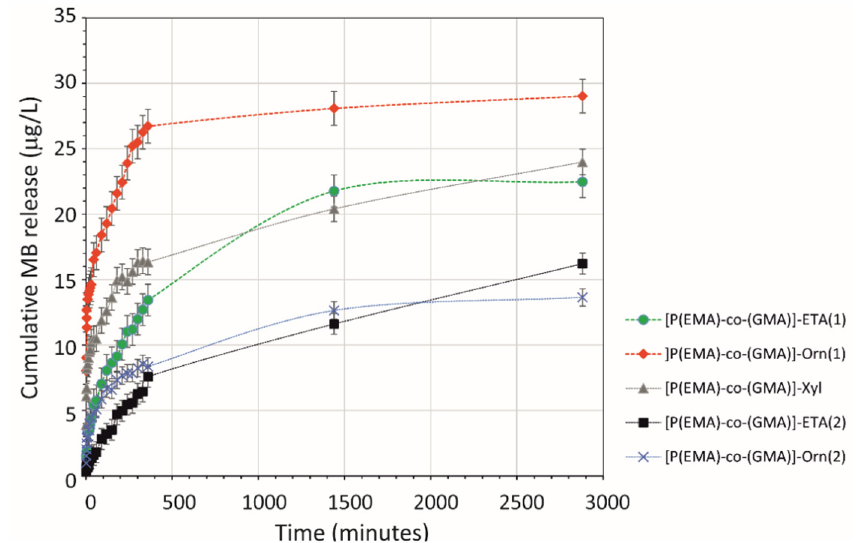
Figure 4. Release profiles of MB from the synthesized oligomers. Determination of the MB concentration was based on spectrophotometric analysis at λ = 633 nm.